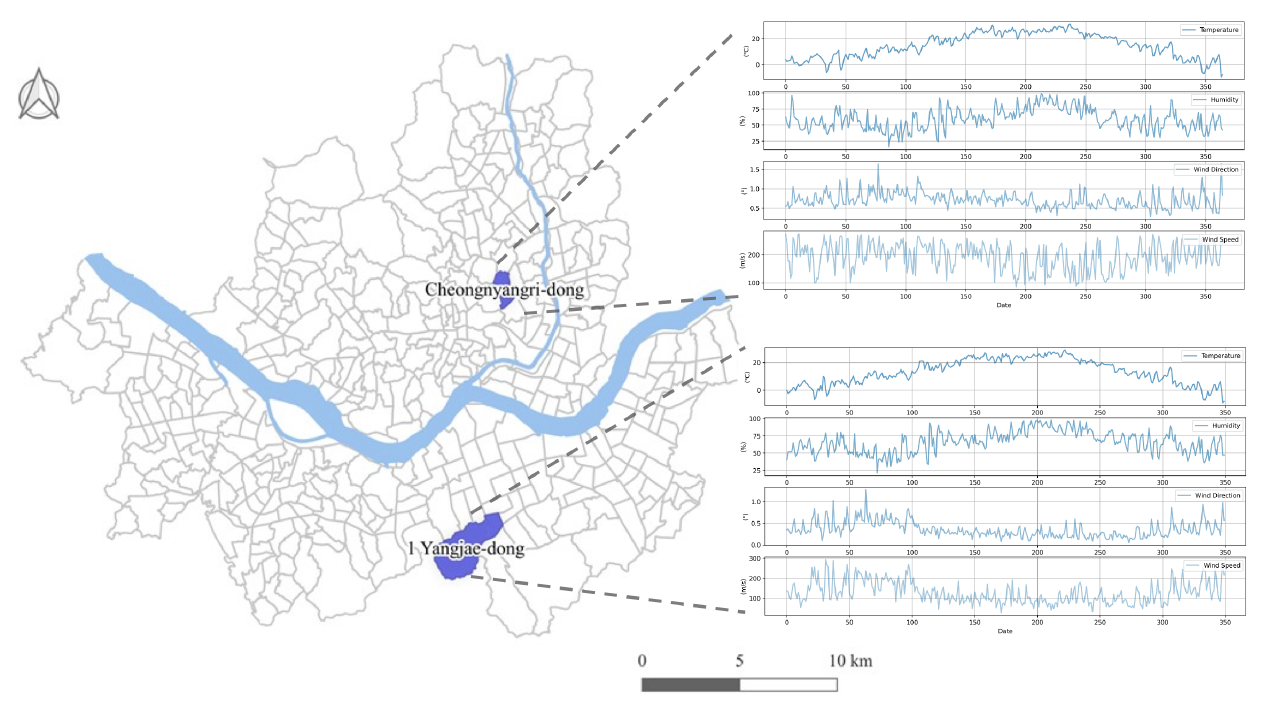
Figure 1. Location map of the study